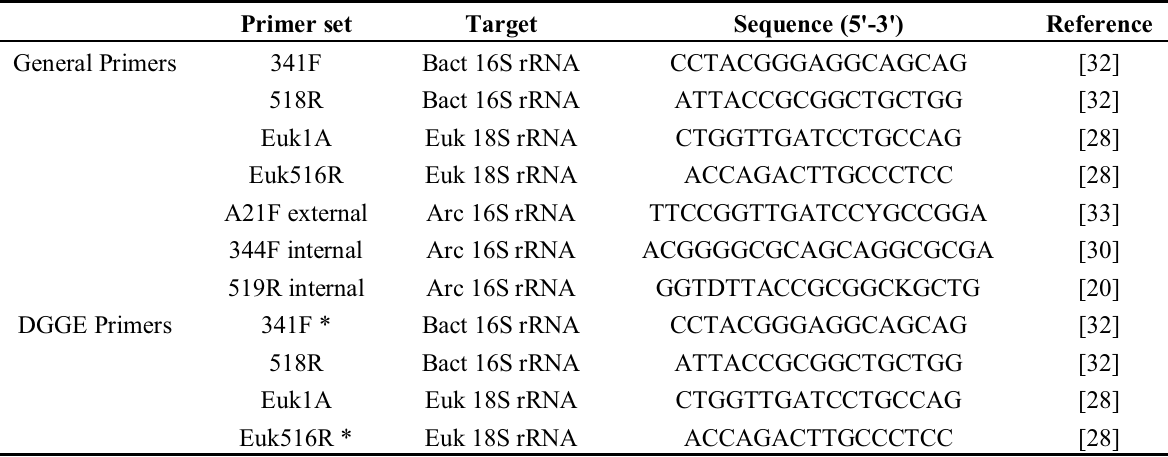
Table 1. PCR primers